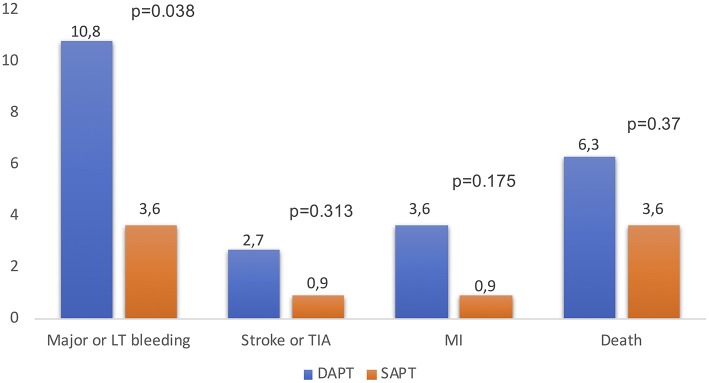
Rates of major or life-threatening events, ischemic stroke or TIA, MI and death after TAVR in DAPT vs. SAPT patients at 3 months, reported in “The ARTE” study (23). DAPT, dual antiplatelet therapy; SAPT, single antiplatelet therapy; LT, life-threatening; TIA, transient ischemic attack; MI, myocardial infarction.